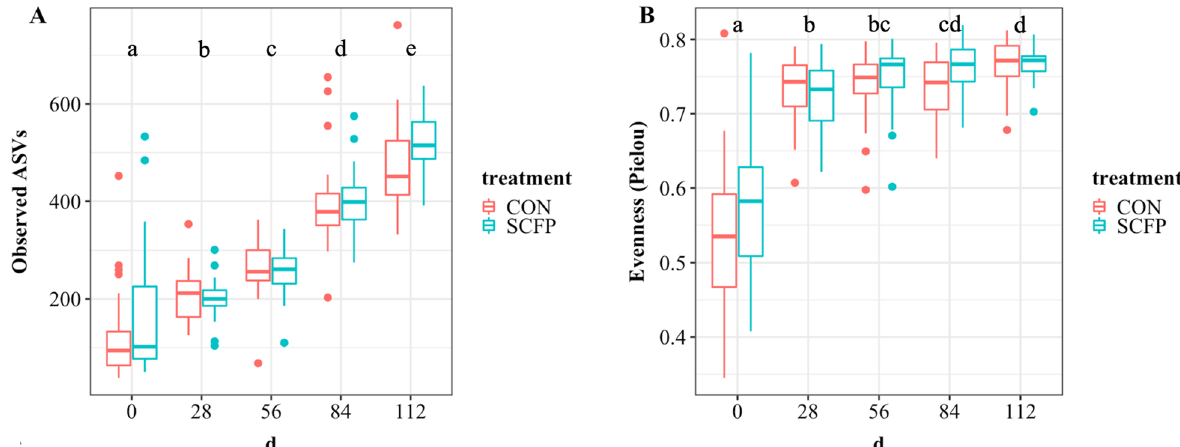
Fig. 1 Calf fecal alpha diversity measured by observed ASVs ( A ) and Pielou Index (evenness) ( B ) was significantly affected by time (0, 28, 56, 84, and 112 d). Letters (a–e) indicate significant differences ( P < 0.05) between each time point but not between treatments